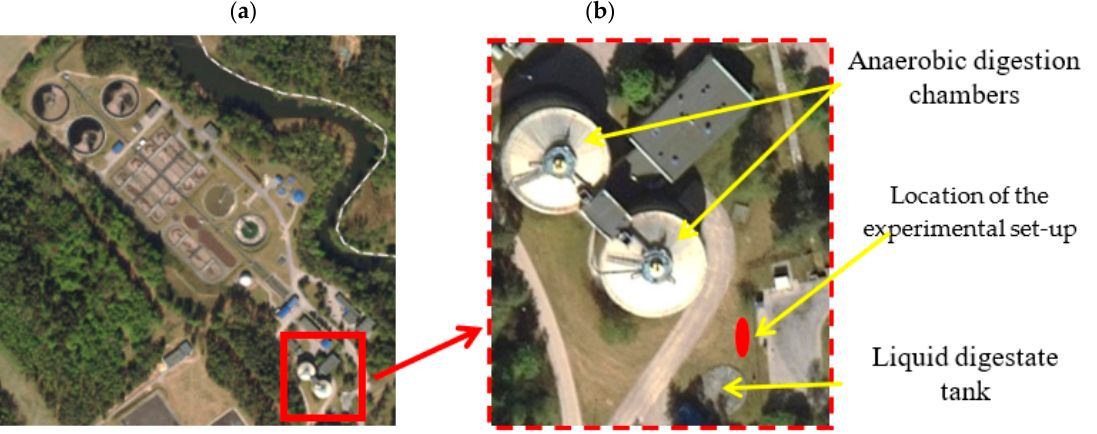
Figure 2. Location of the experiment ( a ) general view of the MWWTP “Łyna” in Olsztyn, ( b ) location of the semi-industrial H-PBR.